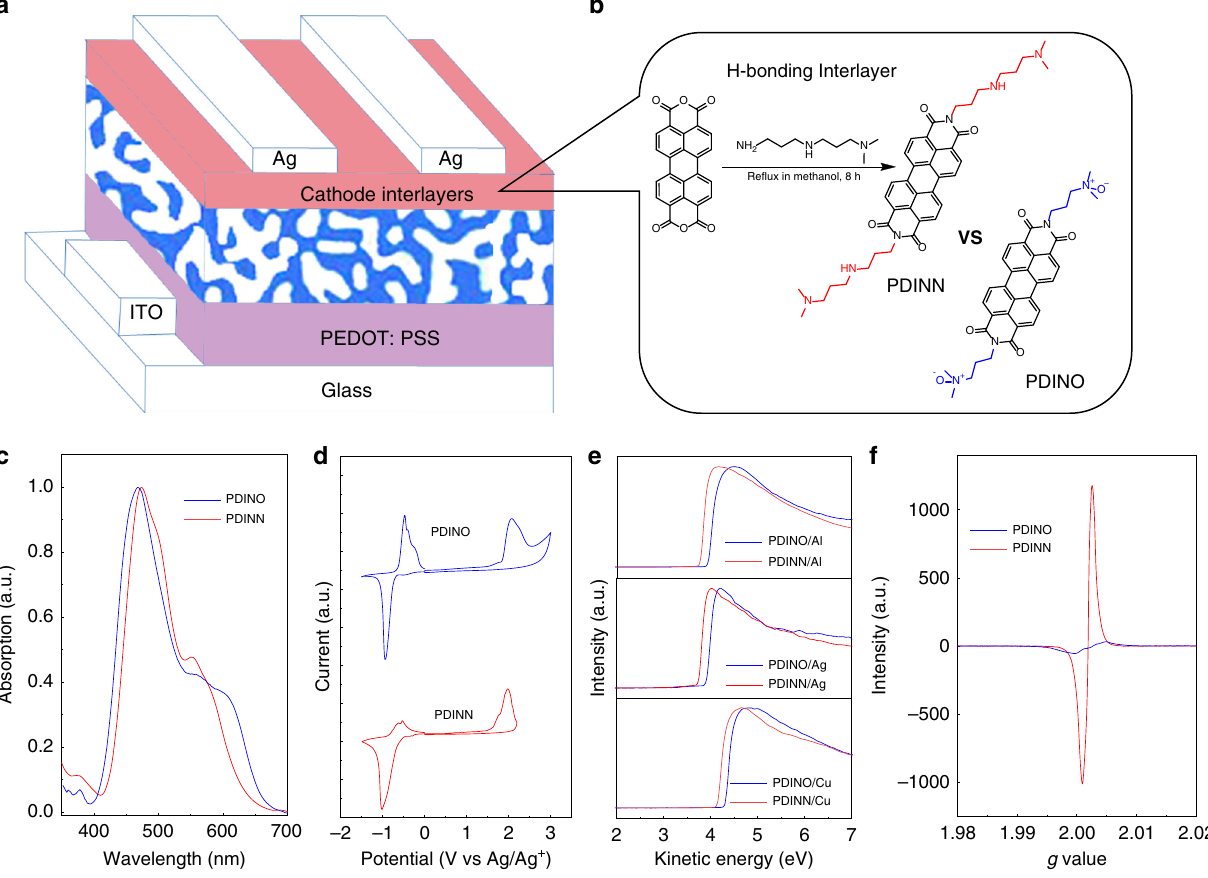
Fig. 1 Chemical structures and characterization of the PDI derivatives CIMs. a Device structure of the OSCs. b Synthetic route of PDINN along with the chemical structures of PDINN and PDINO. c Normalized UV – vis fi lm absorption spectra of PDINN and PDINO fi lms. d Cyclic voltammograms of PDINN and PDINO. e UPS spectra of the PDINN and PDINO-treated electrodes. f Electron spin resonance spectra of PDINN and PDINO in